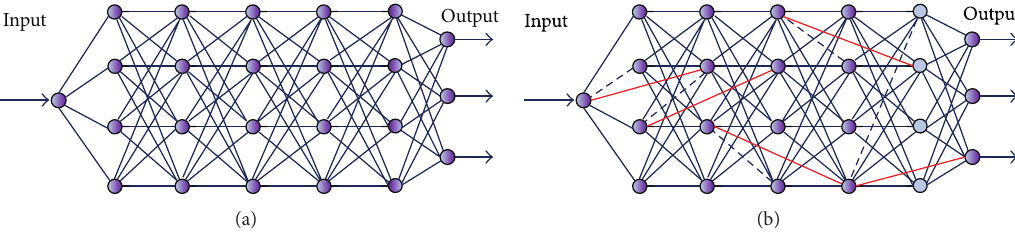
Figure 6: The construction progress of the multilayer feedforward WS small-world neural network. (a) The regular network ( 𝑃 = 0 ). (b) The multilayer feedforward WS small-world neural network ( 0 < 𝑃 < 1 ).